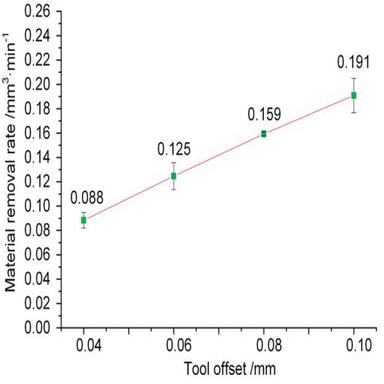
Material removal rate versus wheel speed.